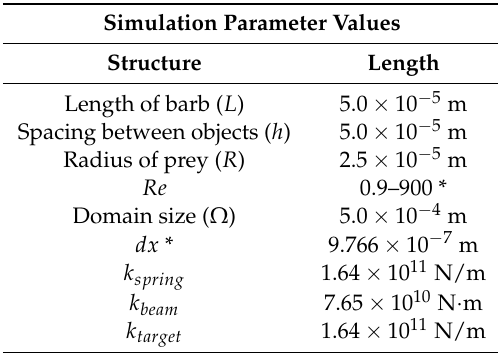
Table 2. Parameters used in simulations. The size of the fluid domain was chosen to be 10 times the length of the structures. The spacing between the length of the barb and the prey was chosen to be the same length as the barb in the base case so that the barb had to travel at least one body length to reach the target prey. * The Reynolds number is calculated using the maximum achieved barb velocity at the end of the acceleration phase. * The mesh size varies from 128–512 points in both the x and y directions, and dx is reported for the finest mesh of the adaptive mesh